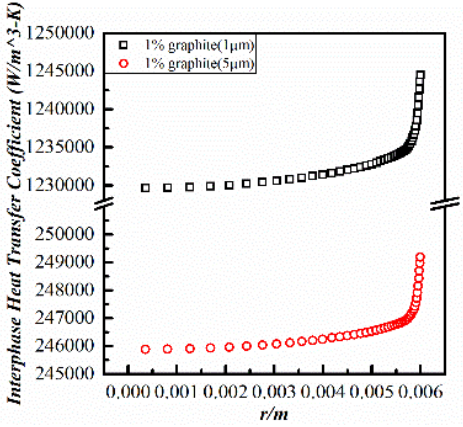
Figure 14. The interphase heat transfer coefficient in the middle cross-section of the tube at Re = 23,000.